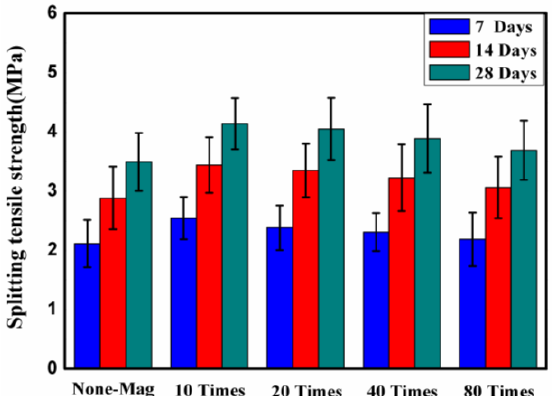
Figure 6. Splitting tensile strength of concrete block pavers after 7, 14, and 28 days of curing in lime-saturated water.